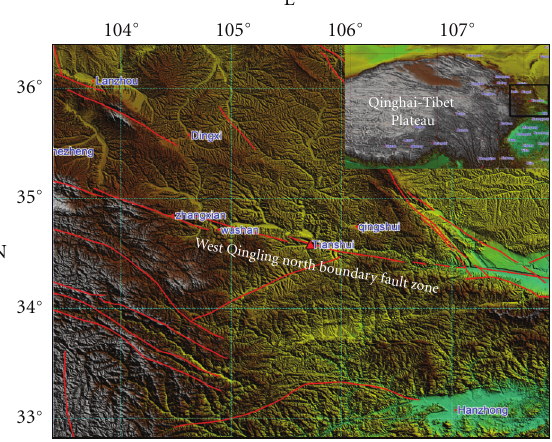
Figure 1: The study area and Holocene faults (red